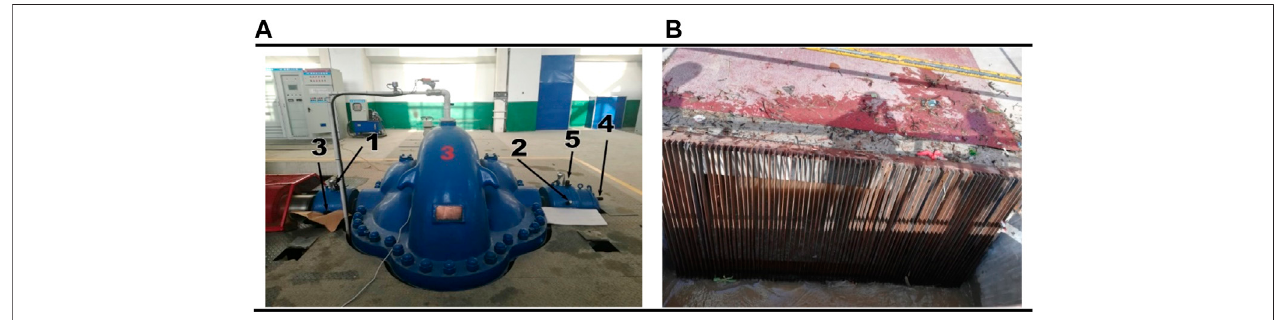
FIGURE 2 | Experimental scheme: (A) monitoring points; (B) trash